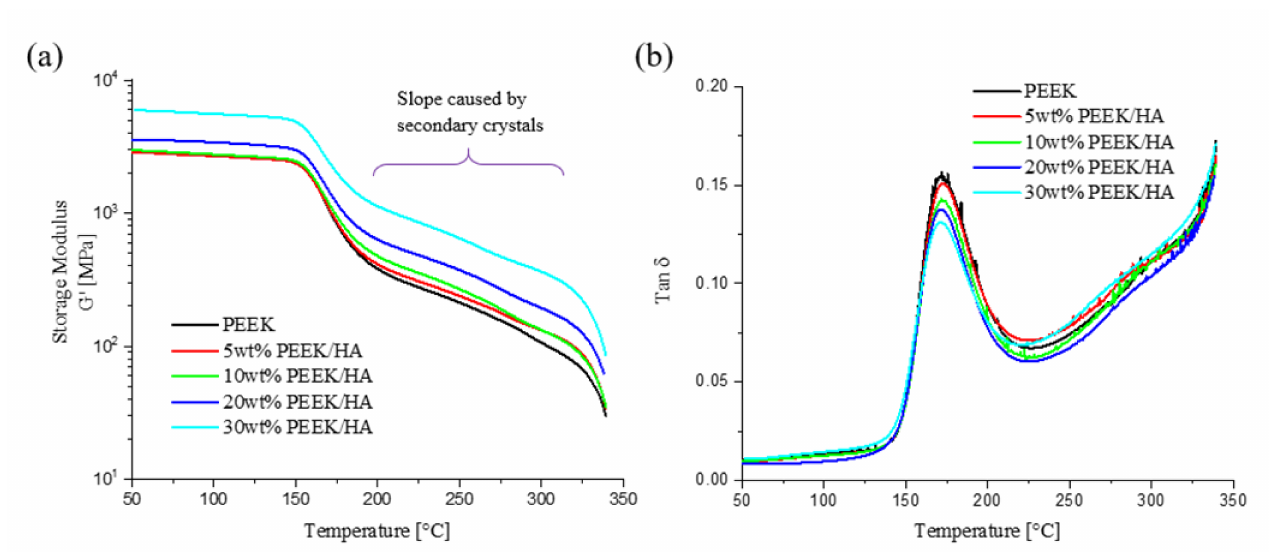
Figure 2. DMTA profiles for 3DP specimens: ( a ) Storage modulus vs. temperature, ( b ) Tan δ vs.